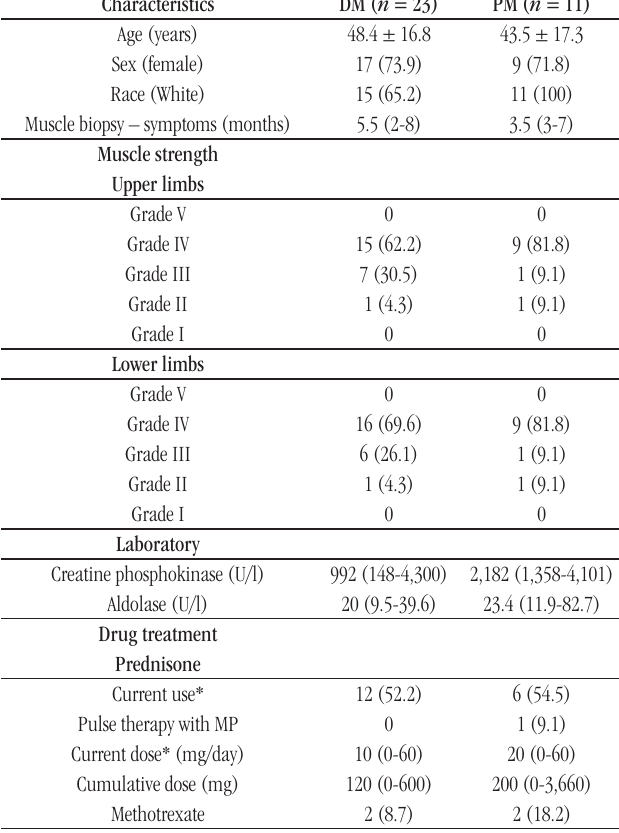
taBLE 1 − Demographic, clinical and laboratory profile of patients with DM and PM